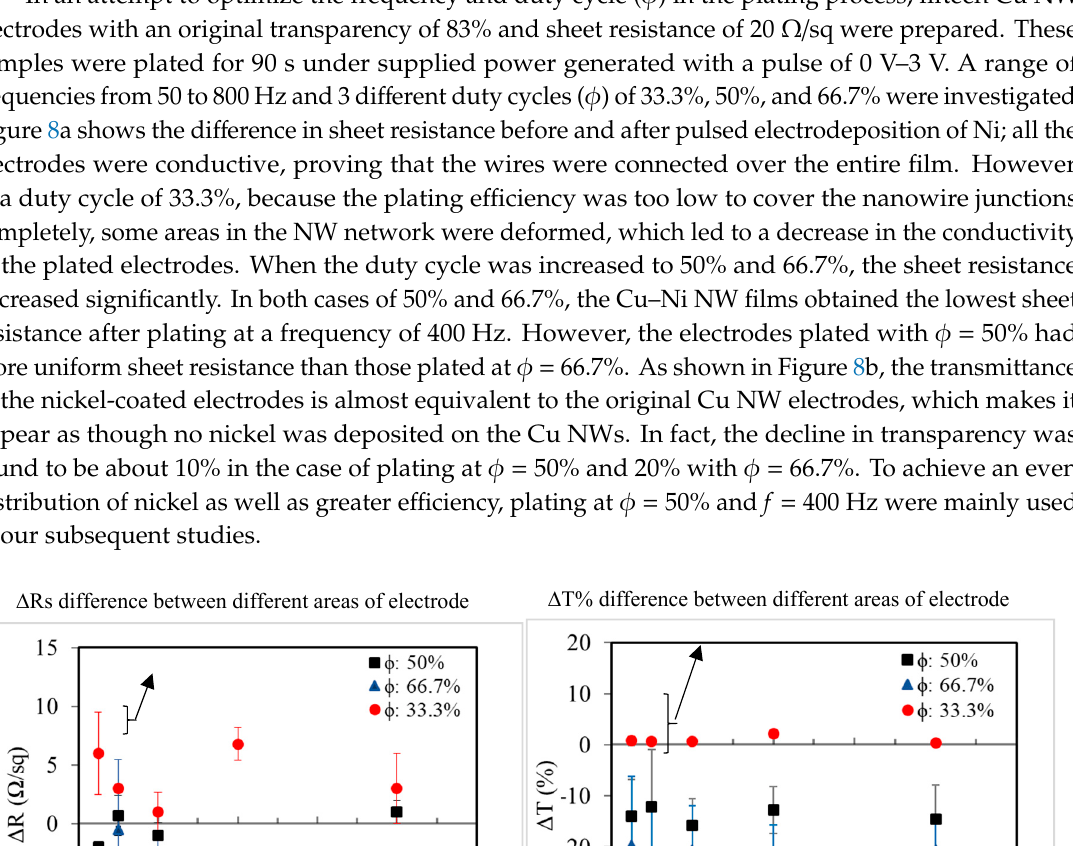
Figure 8. The change in ( a ) sheet resistance— Δ R and ( b ) transmittance— Δ T after nickel plating with various frequencies ( f ) and duty cycles ( ϕ ).